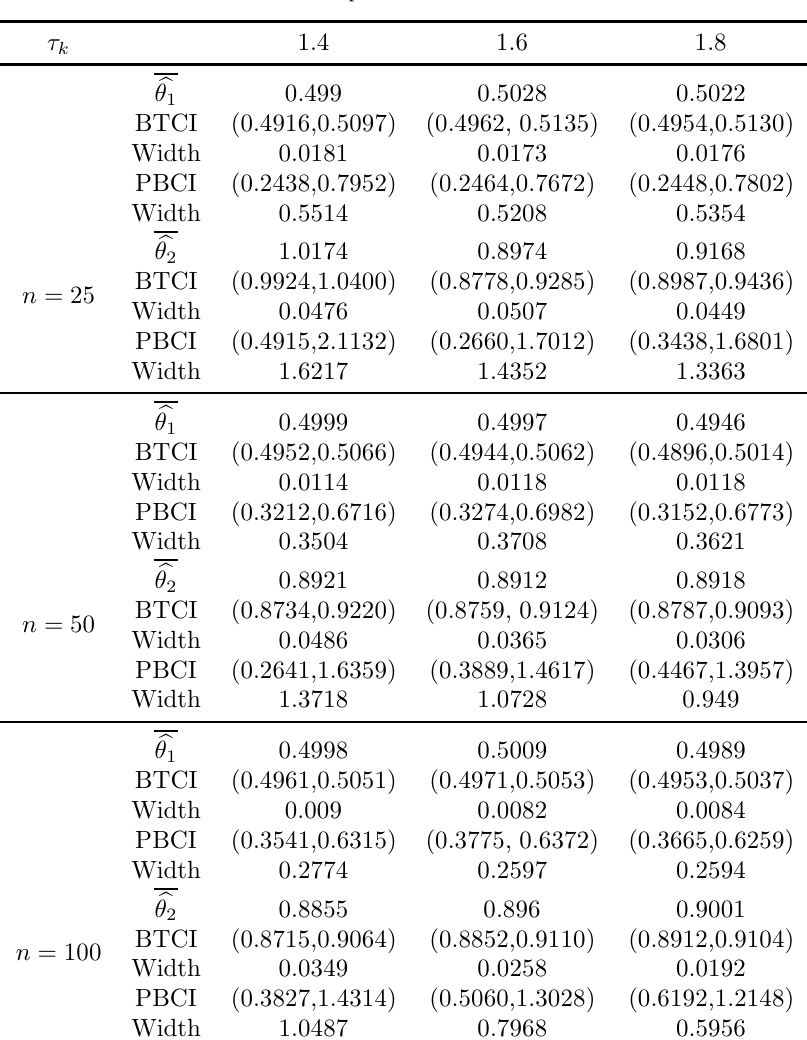
Bootstrap CIs with τ = 1 .